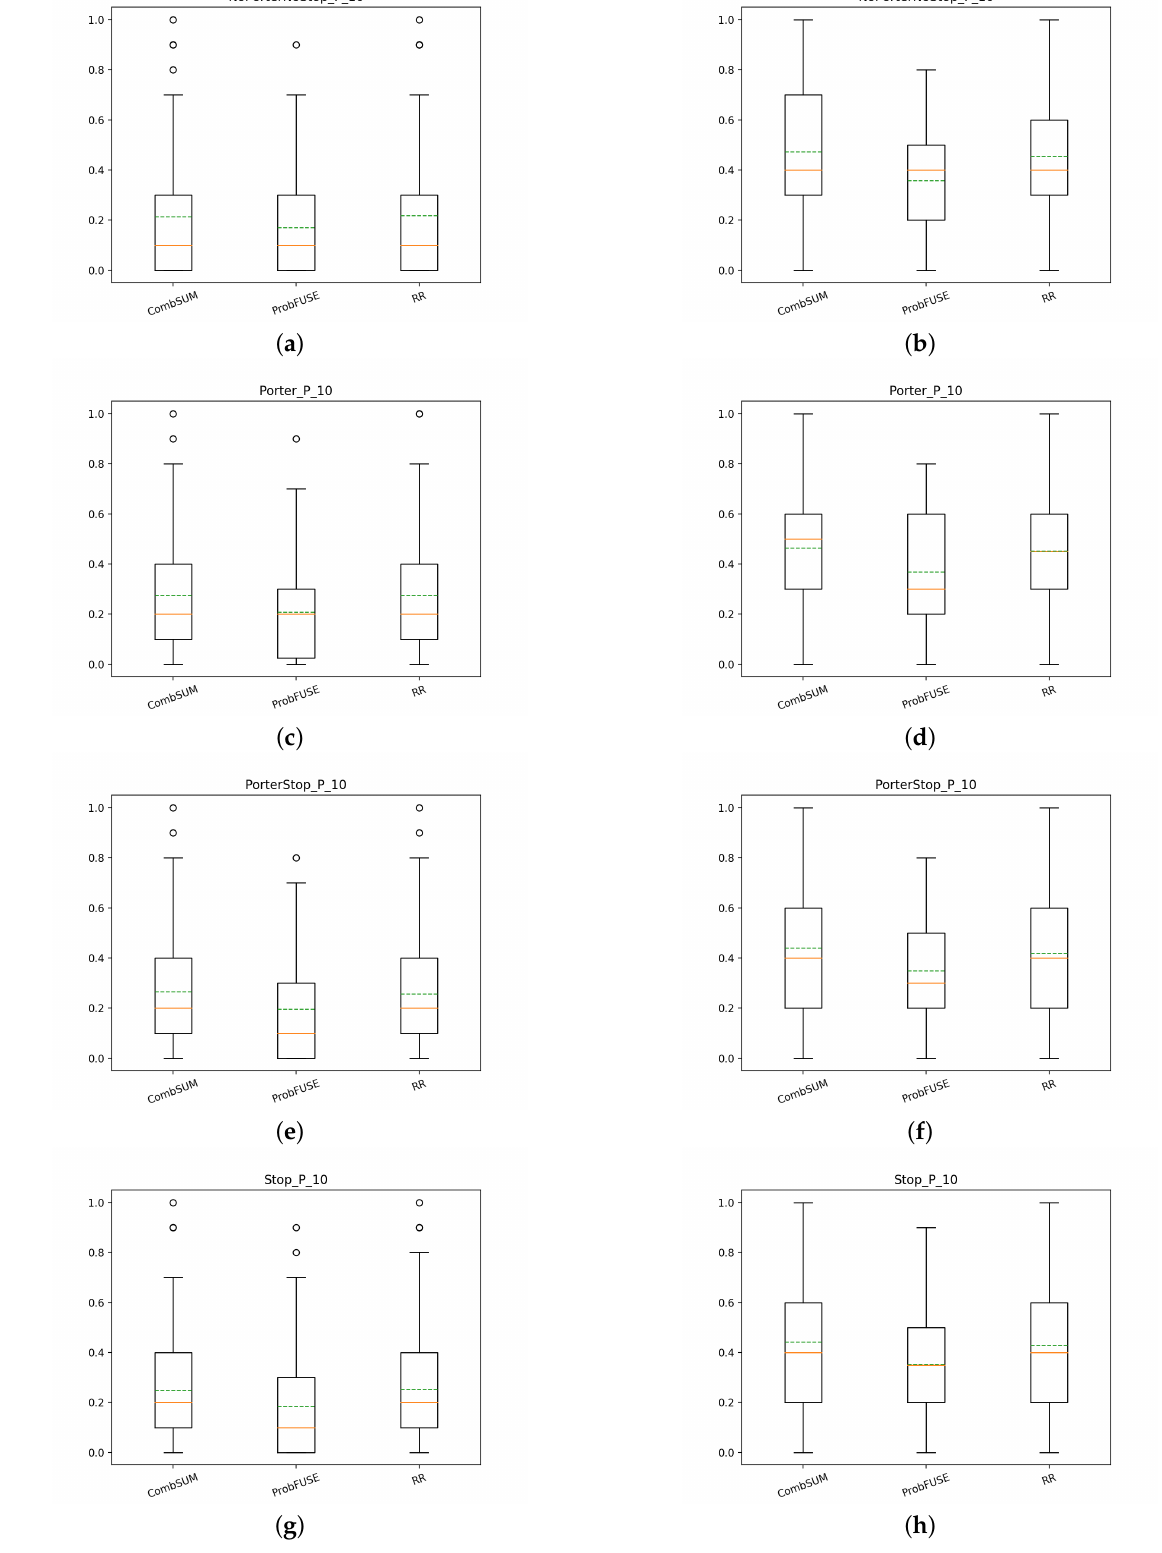
Figure 14. T2: box plots of P@10 of the fusion methods: ( a ) NoPorterNoStop fusions of the runs, ( b ) NoPorterNoStop+QR+RF fusions of the runs, ( c ) Porter fusions of the runs, ( d ) Porter+QE+RF fusions of the runs, ( e ) PorterStop fusions of the runs, ( f ) PorterStop+QE+RF fusions of the runs, ( g ) Stop fusions of the runs, ( h ) Stop+QE+RF fusions of the